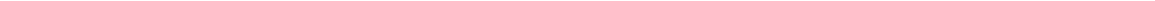
Fig. 5 Competition of the G γ proteins in interacting with RGB1. a Interactions of GS3, DEP1 and GGC2 with RGB1 using yeast two-hybrid assay. GS3 interacts with RGB1 through the OSR domain but not the C-terminal cysteine-rich domain (TV). OSR: OSR domain of GS3, amino acid 1-94; TV: cysteine- rich domain of GS3, amino acid 95-231. AD: GAL4 activation domain; BD: GAL4 binding domain. -LW: selective medium lacking Trp and Leu; -LWHA: selective medium lacking Trp, Leu, His and Ade. b Interactions of GS3, DEP1 and GGC2 with RGB1 using BiFC assay. Bar = 20 μ m. c Interactions of GS3, GGC2 and DEP1 (fused to C-terminal fragment of fi re fl y luciferase) with RGB1 (fused to N-terminal fragment of fi re fl y luciferase) using luciferase activity assay. Rice protoplasts with transient expression of RGB1-nLuc plus cLuc-DEP1, cLuc-GGC2, cLuc-GS3-1, and cLuc-GS3-4, but not the C-terminal cysteine- rich domain (TV), show high luciferase activity relative to the control. Empty vectors of cLuc plus RGB1-nLuc, and nLuc plus cLuc-DEP1, cLuc-GGC2, cLuc- GS3-1, and cLuc-GS3-4 were used as the negative control. Data are normalized to the internal control 35 S::REN. Values are given as mean ± SEM ( n = 3). Different letters indicate signi fi cant differences ranked by the LSD test ( P < 0.05). d Interactions of DEP1 and GGC2 with RGB1 in the background of